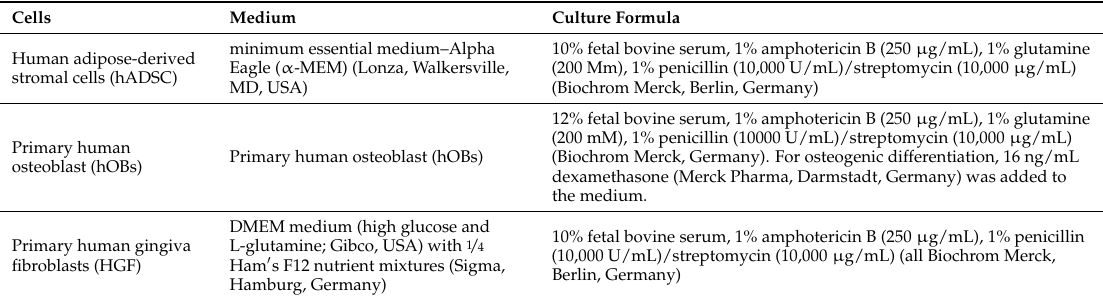
Table 1. Culture